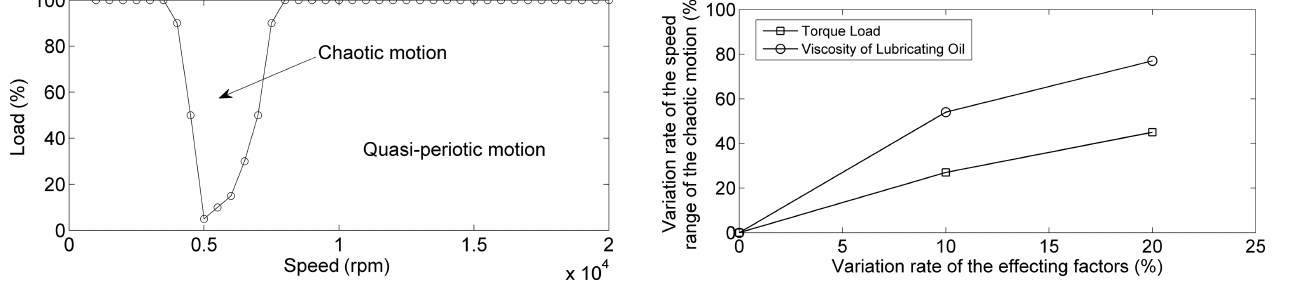
Figure 13. Dimensionless critical torque load. Figure 14. Sensitivity analysis